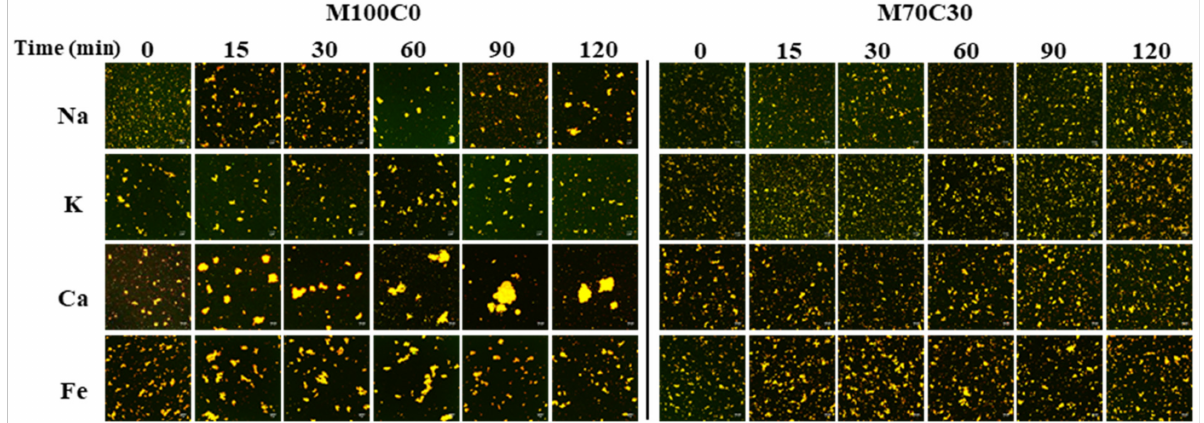
Figure 7. CLSM images of emulsions with different ions after digestion. The pictures are overlays of Nile-red-labeled oil phase and FITC-labeled protein. The scale bar is 20 µ m.